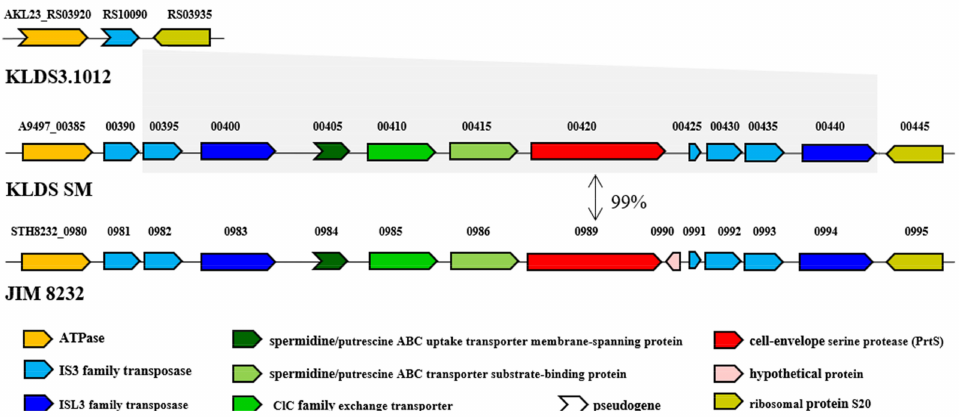
Figure 5. Chromosomal region targeted by the prtS gene in the genome of S. thermophilus KLDS3.1012, S. thermophilus KLDS SM and S. thermophilus JIM